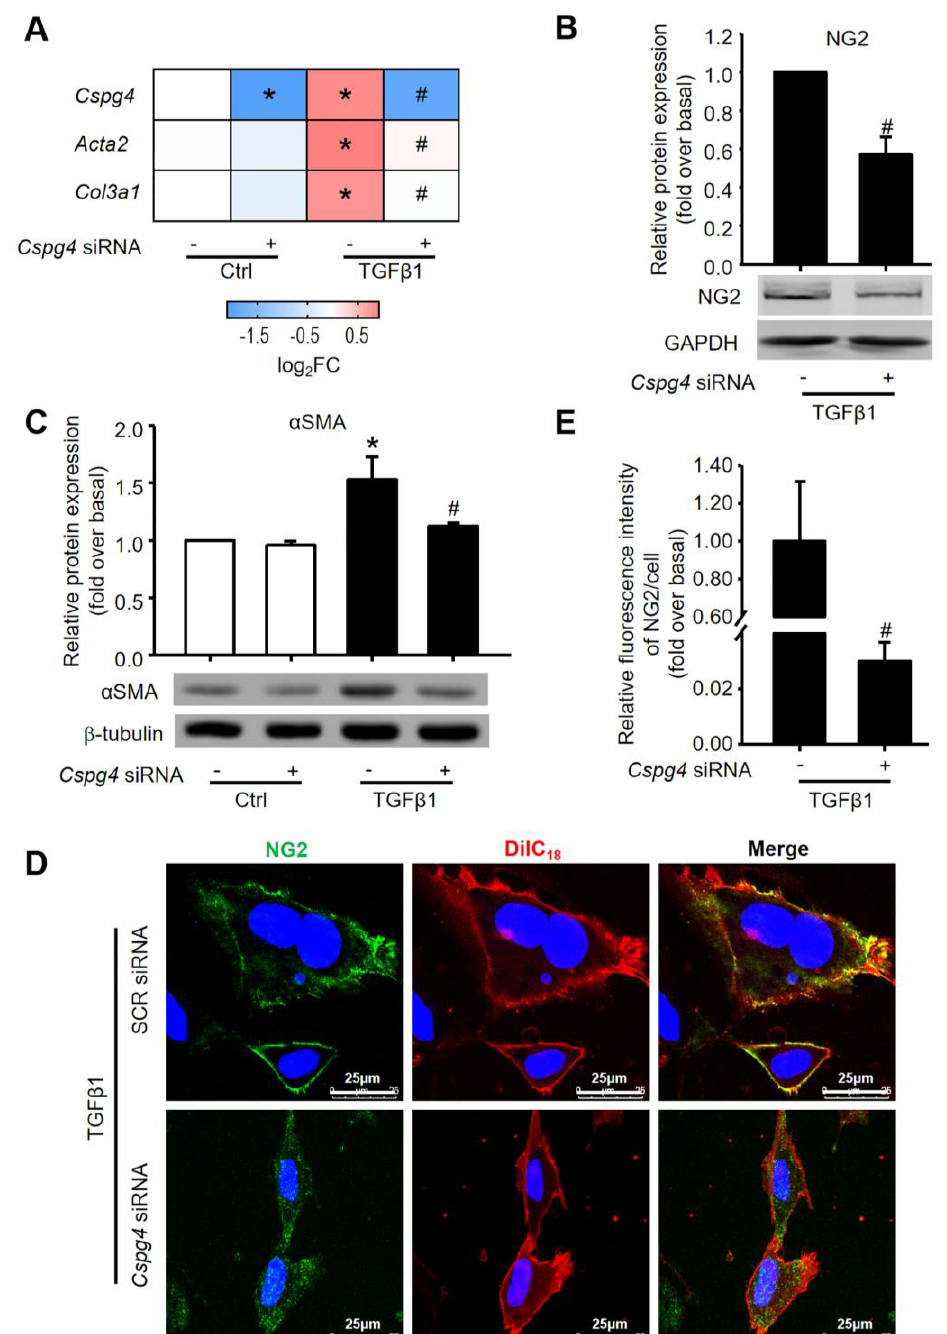
Figure 5. The involvement of NG2 in TGF β 1-induced BMSC differentiation. BMSC were transfected with Cspg4 siRNA and followed by 24 h of TGF β 1 treatment. ( A ) The mRNA expression of Cspg4 , Acta2 and Col3a1 in TGF β 1-treated BMSC in the presence or absence of Cspg4 siRNA. ( B ) The protein expression of NG2 in TGF β 1-treated BMSC in the presence or absence of Cspg4 siRNA. ( C ) The protein expression of α SMA in TGF β 1-treated BMSC in the presence or absence of Cspg4 siRNA. ( D ) Immunofluorescent staining for NG2 (green) in TGF β 1-treated BMSC in the presence or absence of Cspg4 siRNA. Cell membrane was labeled with a membrane dye DiIC 18 (red). DAPI was used to visualize nuclei (blue). ( E ) Quantitative analysis of the fluorescence intensity of NG2 with Image J software. Data are presented as the mean ± SEM. n = 3 per group. * p < 0.05 vs. control. # p < 0.05 vs. TGF β 1 group.